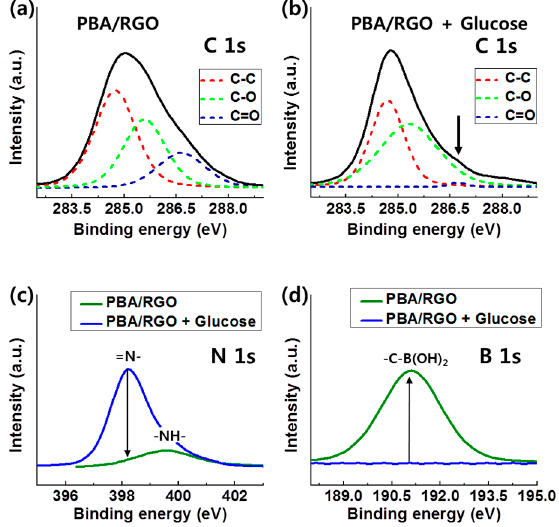
Figure 3. XPS results of PBA/RGO interconnector before and after adding glucose in ( a , b ) C 1s, ( c ) N 1s, and ( d ) B 1s orbital.